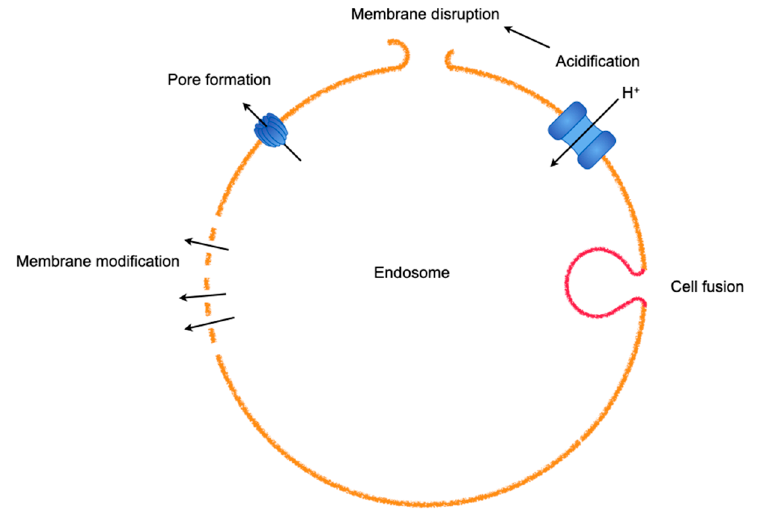
Figure 3. An array of methods used by viruses to escape from entrapment by endosomes. A virus often harnesses various machineries in combination.